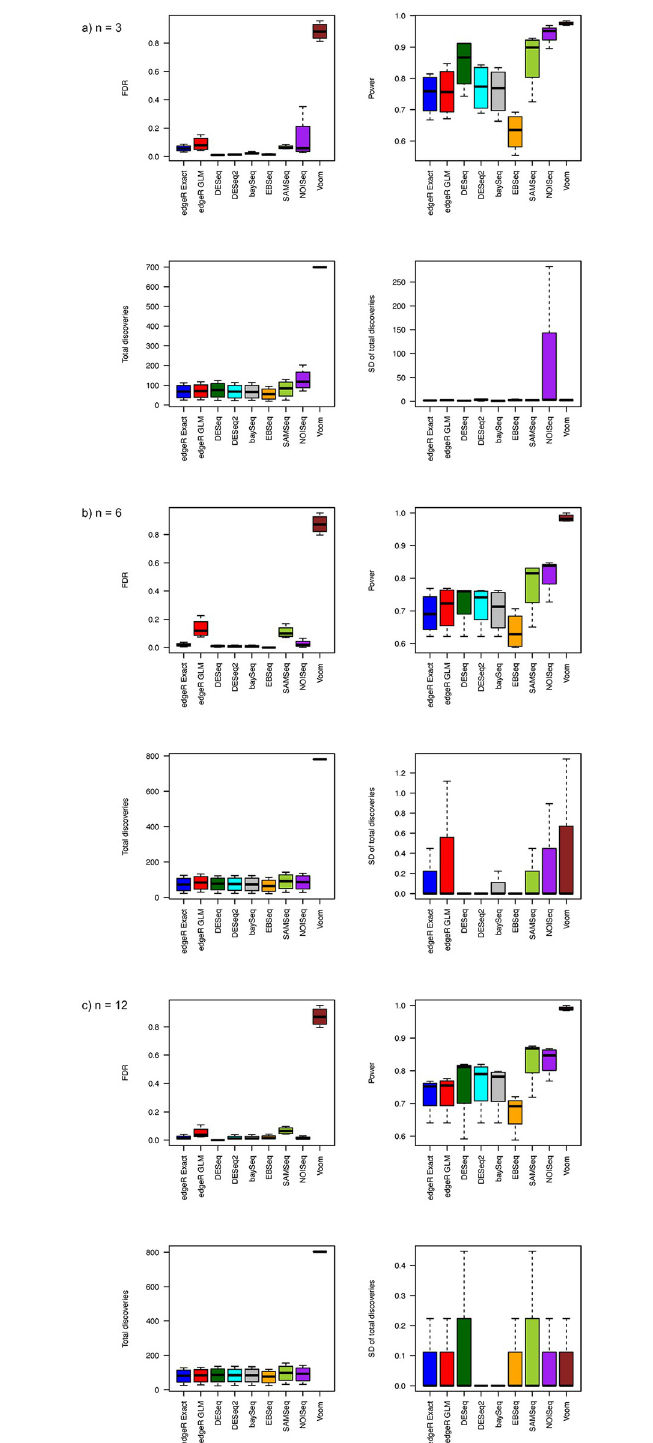
Fig 3. Estimated FDRs, powers, means of total discoveries, and SD of total discoveries from different RNA-Seq differential analysis methods with log-normal distribution assumption and equal library size for a) n = 3, b) n = 6, and c) n =